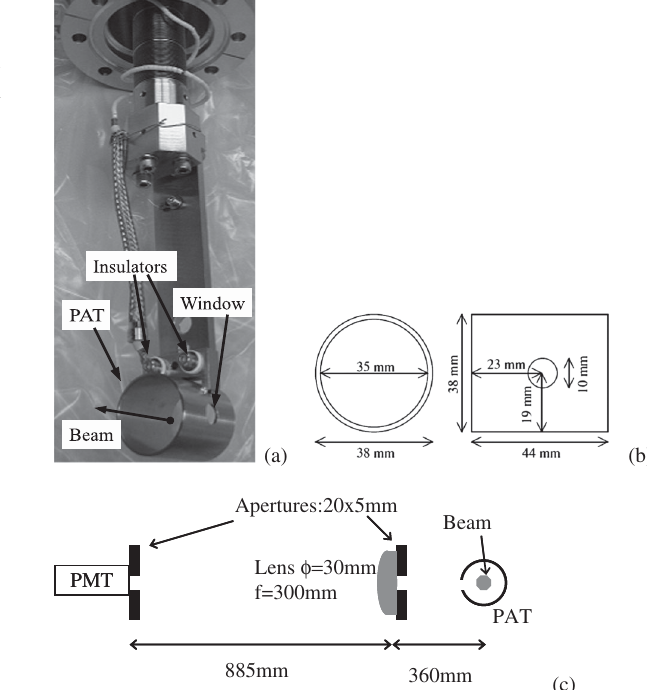
FIG. 6. Results of tune measurements. The fractional parts of the horizontal, vertical, and synchrotron tunes are plotted as functions of the rf cavity voltage. The integer parts of the horizontal and vertical tunes are 2 and 1, respectively. The distance between the horizontal and synchrotron tunes on cou- pling resonance ( (cid:4) 30 V ) depends on the coupling strength.